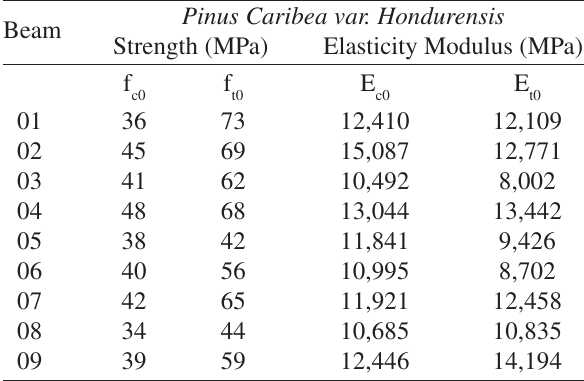
Table 4. Mean strength and modulus of elasticity values.